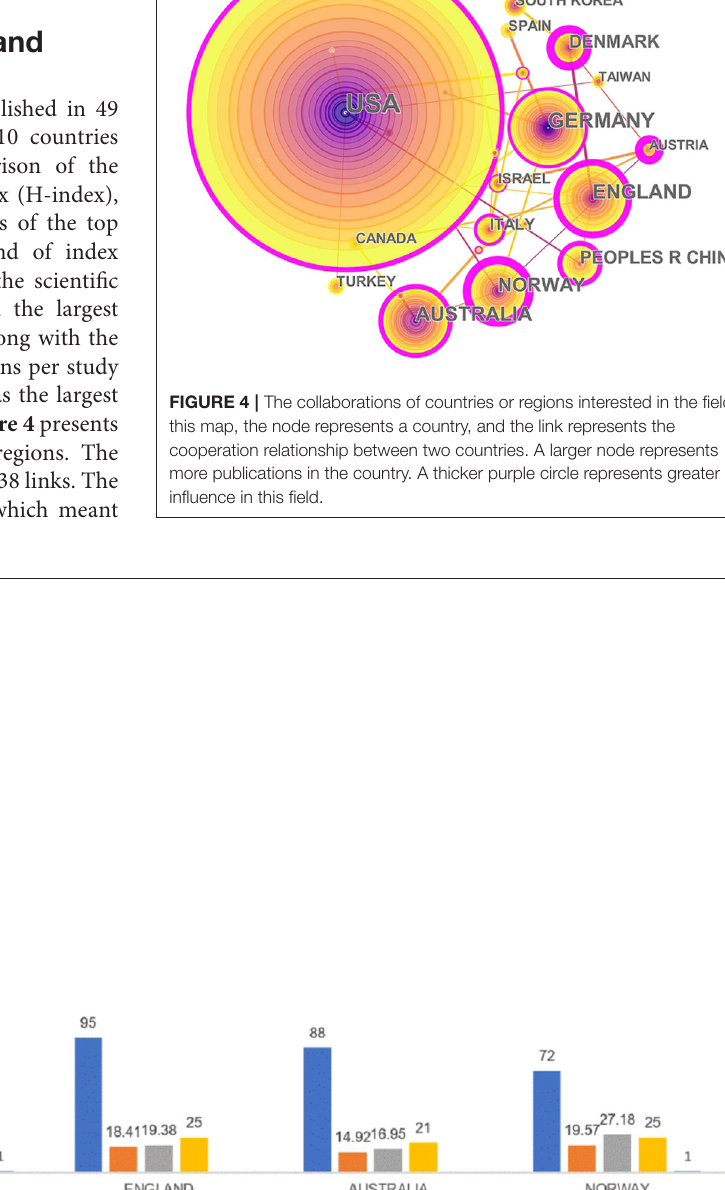
Frontiers in Psychology |